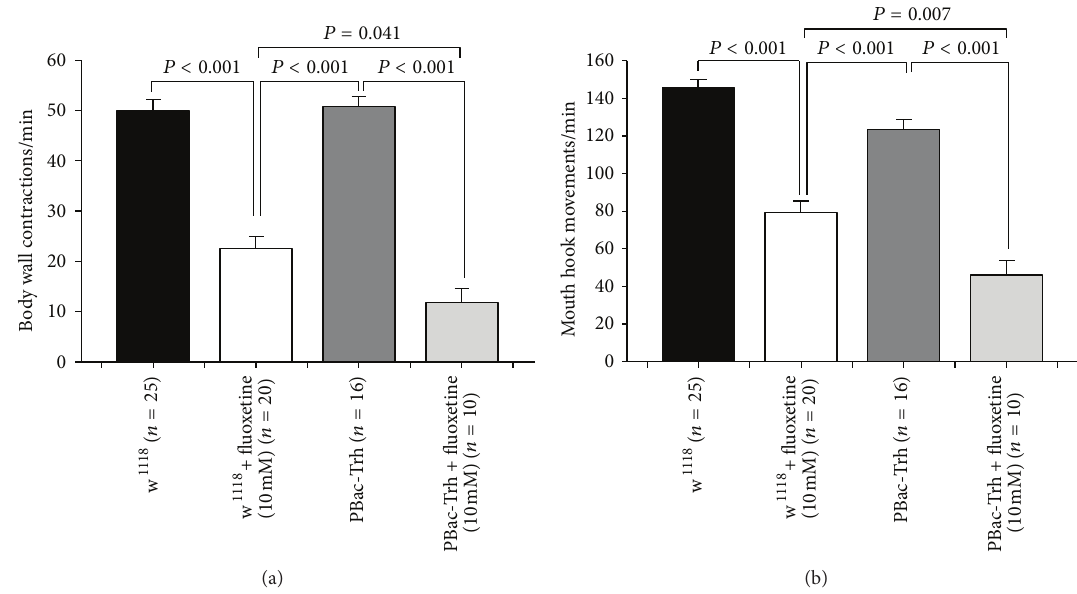
Figure 5: Serotonin reuptake inhibitor (SSRI), fluoxetine, influences both locomotion and feeding behaviors. (a) Fluoxetine significantly decreased body wall contractions. Interestingly, fluoxetine had a greater effect on tryptophan hydroxylase (Trh) mutant animals than w 1118 animals. (b) Fluoxetine significantly reduced mouth hook movements. Fluoxetine, also, had a greater effect on tryptophan hydroxylase (Trh) insertional mutant (homozygous) animals than w 1118 animals. One-way ANOVA was used for comparison, and Bonferroni 𝑡 -test was employed to compare treatments. Data represented as mean ± SEM.